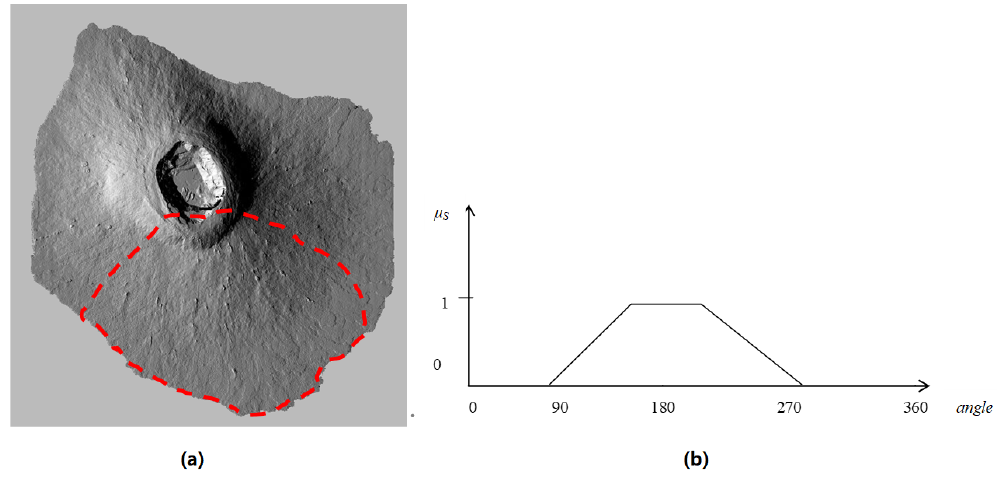
Figure 4. The south slope area of ( a ) a volcano and ( b ) its membership